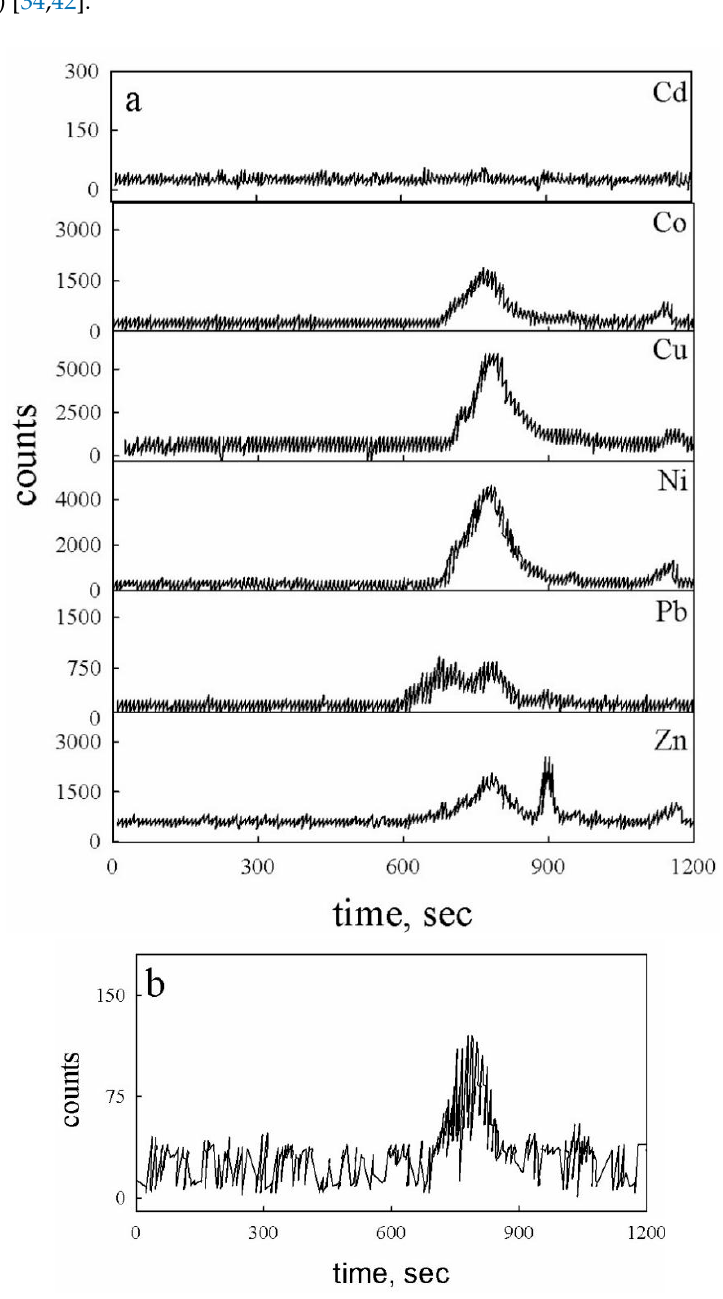
Figure 3. ( a ) High-performance size exclusion chromatography to inductively coupled mass spectrometry (HPSEC-ICP-MS) chromatogram for Cd, Co, Cu, Ni, Pb, and Zn. ( b ) HPSEC-ICP-MS chromatogram for Cd obtained after addition of 1 µg/L of standard solution to HA sample.